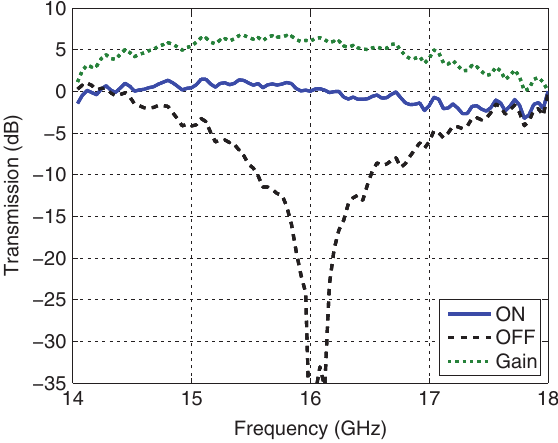
Figure 14: Measured transmission coefficients for the metasurface in Figure 13. The blue curve is the transmission of the signal beam only, whereas the black and green curves are the destructive and constructive interferences of the signal and control beams,